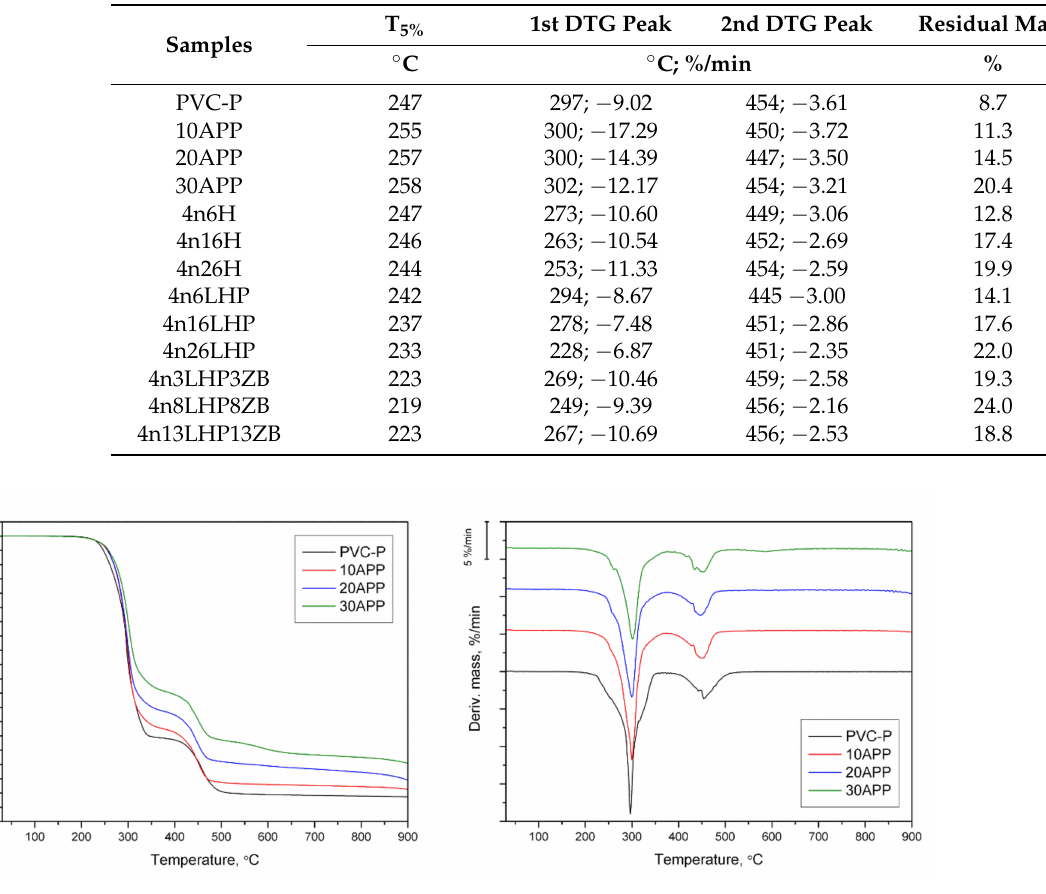
Table 3. TG and DTG data of unmodified PVC-P and thermoplastic with APP or FR